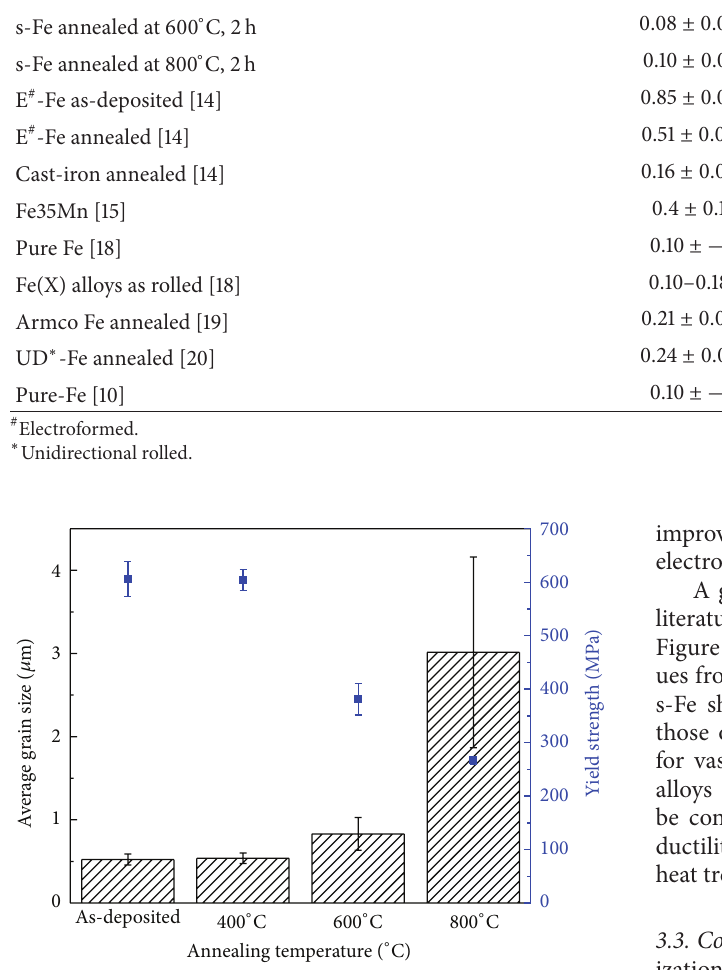
Figure 5: Graphical correlation between grain size, annealing temperature, and the yield strength of s-Fe annealed for two